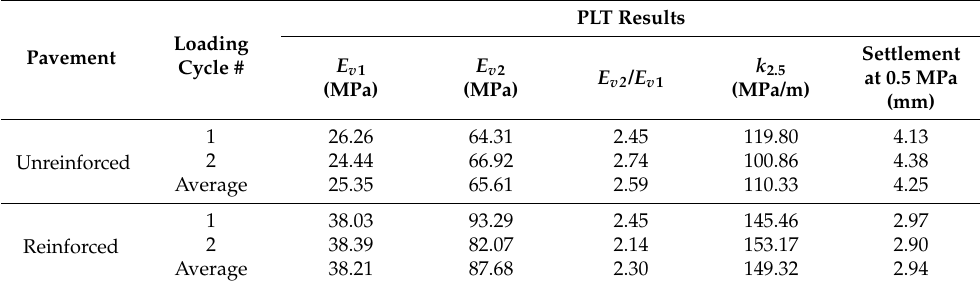
Table 1. PLT results for the two